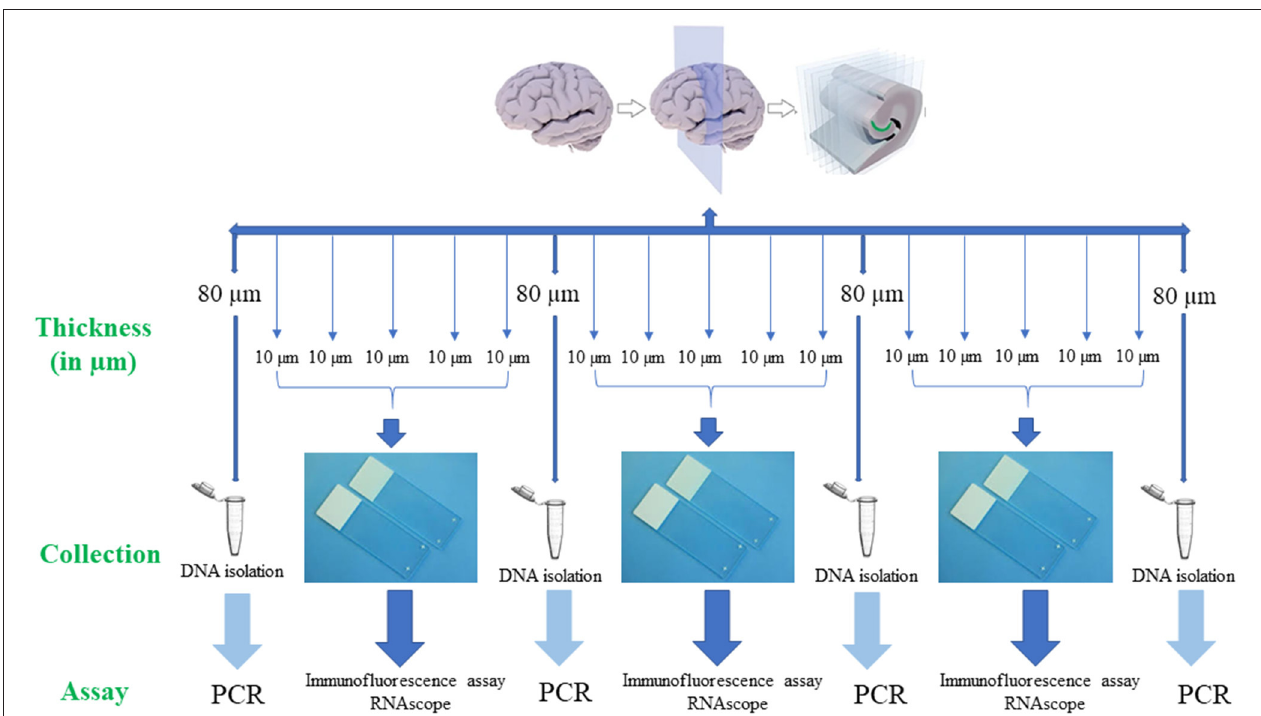
FIGURE 2 | Human brain tissue samples assay design. Serial sections of fresh-frozen samples/fixed tissue samples were analyzed according to the above design. Firstly, 80 µ m thickness of the tissue sample was collected into a 1.5ml microcentrifuge tube for the extraction of the DNA. Next, 5 serial sections each of 10 µ m in thickness that were adhered to a positively charged glass slide were used for immunofluorescence (IFA) and RNAscope assays. If these tissue slices were negative for all the assays, subsequent 6 sections, one of 80 µ m and five of 10 µ m were used for the analysis. This entire process is repeated to a depth of ∼ 500 µ m − 1 mm of the tissue. Once the Borrelial DNA was detected using PCR, the rest of the tissue slices were used for both IFA and RNAscope